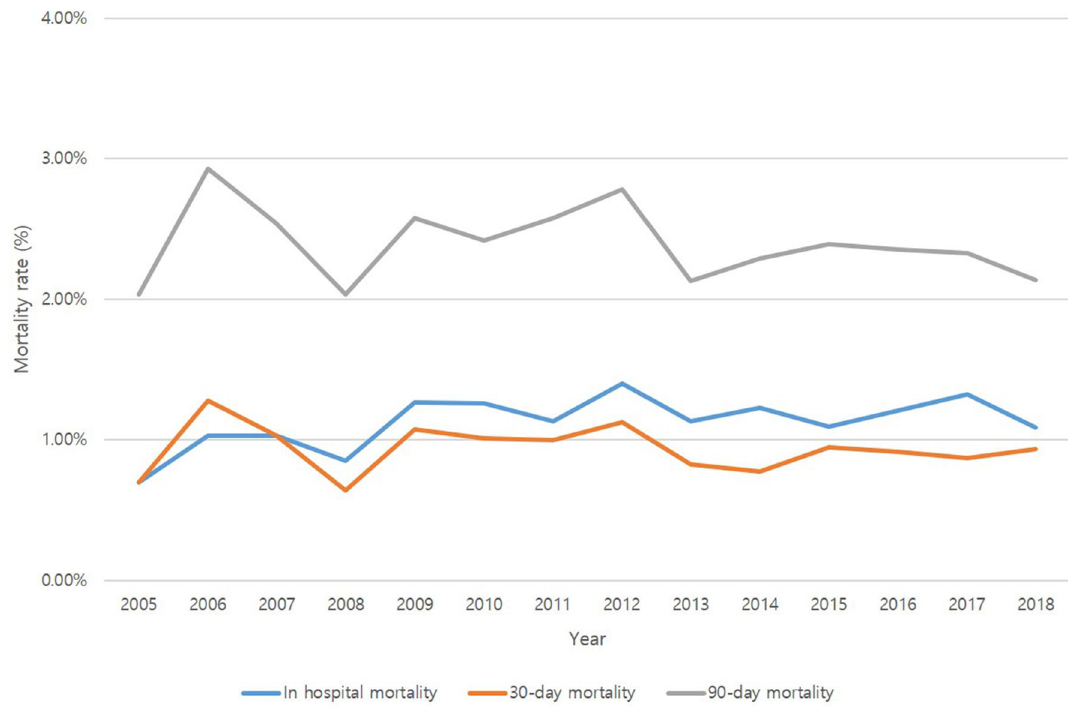
Figure 2. The mortality of septic arthritis by